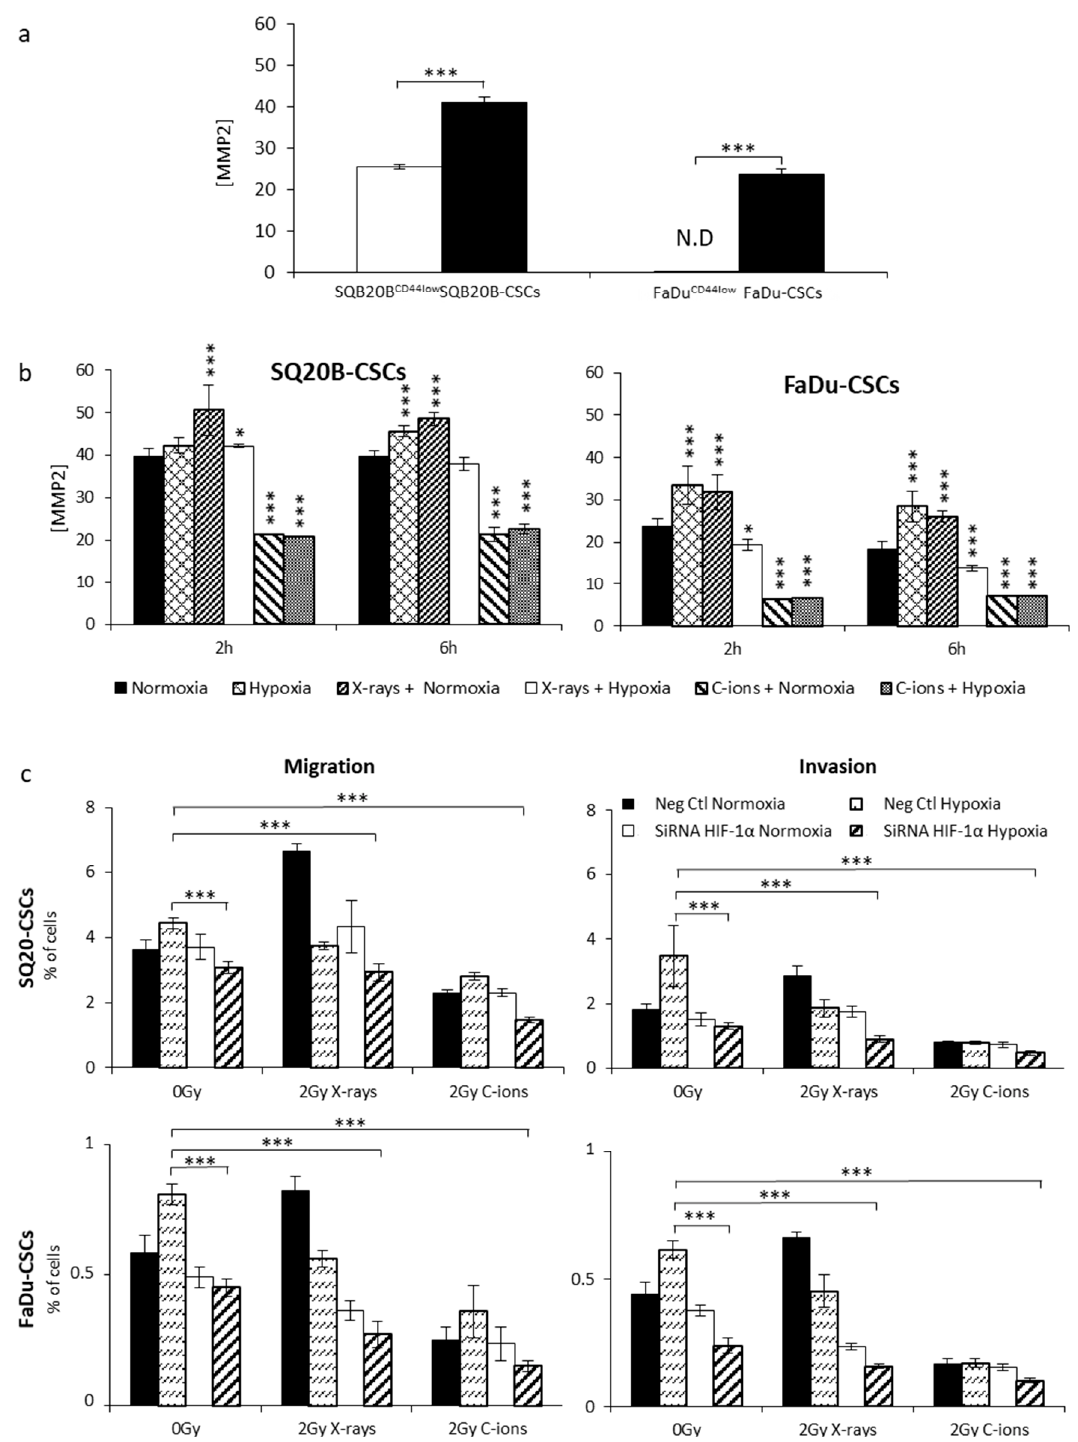
Figure 4. E ff ect of X-ray and C-ion irradiation on migration / invasion processes under normoxia and chronic hypoxia. ( a ) MMP-2 concentrations in SQ20B and FaDu subpopulations normalized to baseline protein levels; n = 3. ( b ) MMP-2 concentrations in SQ20B-CSCs and FaDu-CSCs measured 2 and 6